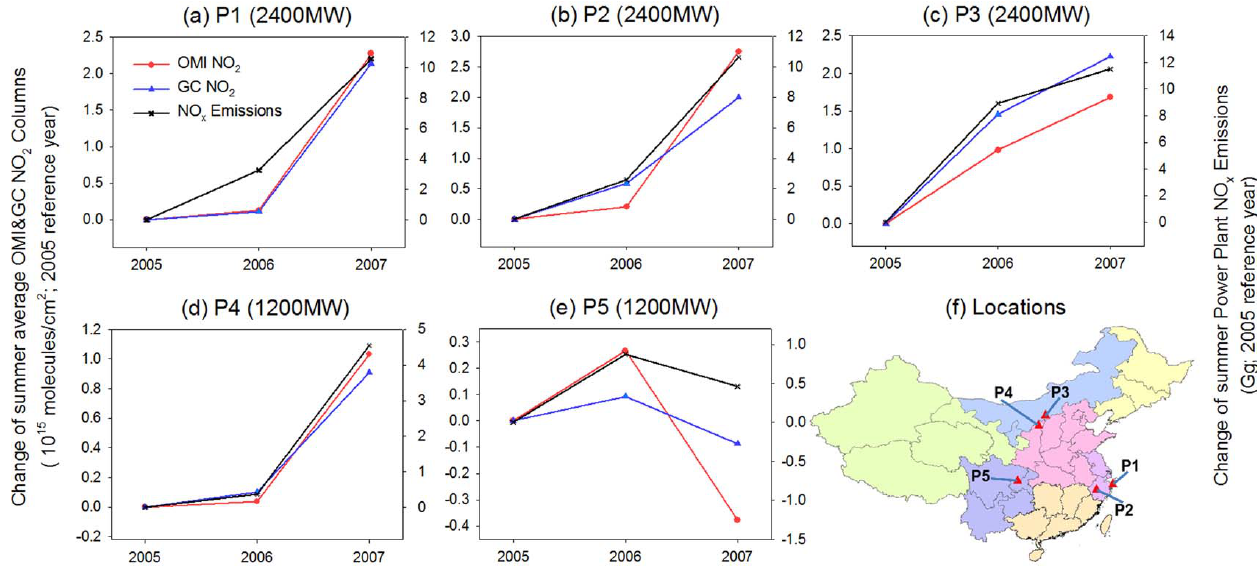
Fig. 10. Changes of summer average OMI and GEOS-Chem tropospheric NO 2 columns and power plant NO x emissions during 2005–2007 (2005 reference year) over five large new power plants. Numbers in the parentheses in the subtitles denote the new generation capacities added during June 2005–August 2007. Locations of the power plants are indicated in (f) .